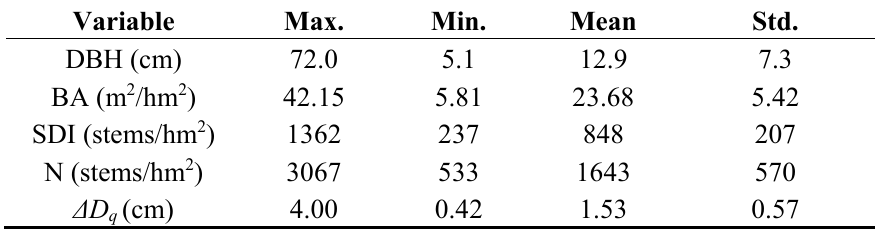
Figure 2. Distribution of total trees and dead trees by diameter classes of Mongolian oak. Table 1. Summary statistics of tree- and plot-level variables for model calibration of Mongolian oak in Wangqing Forestry Bureau, Northeast China ( n =